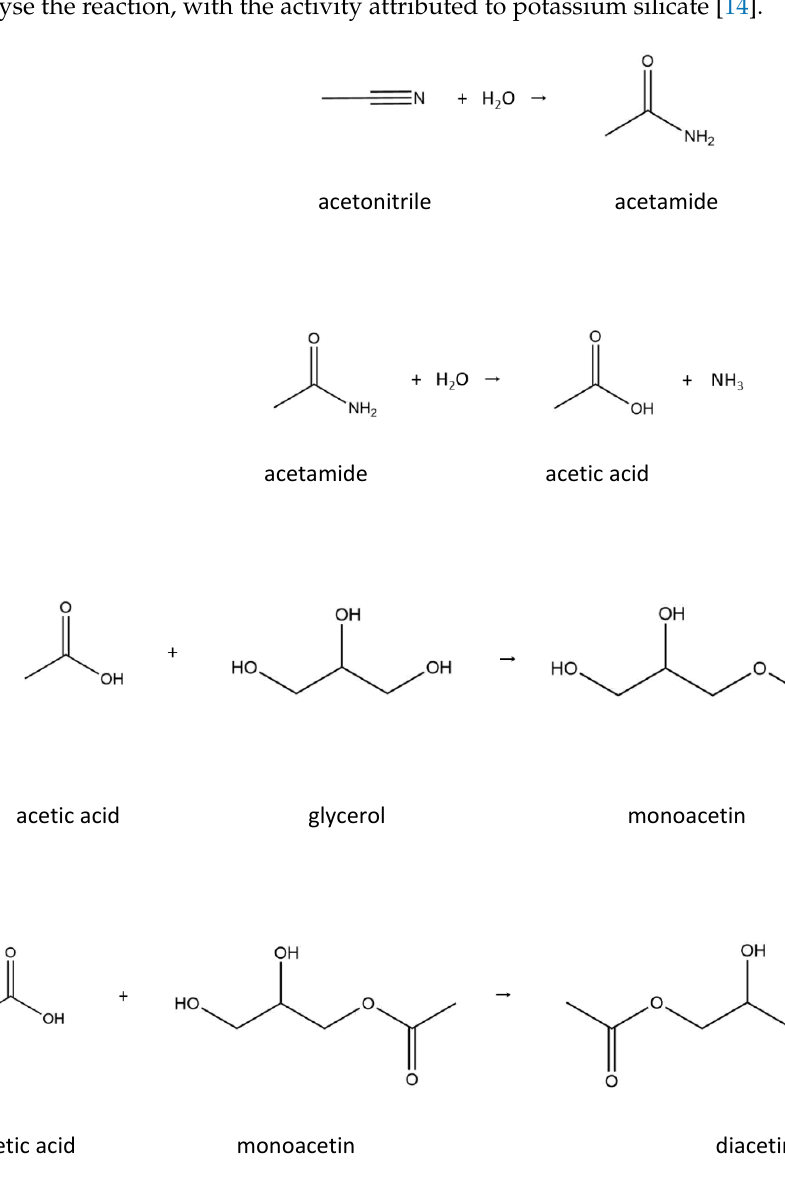
Figure 3. Reactions for the formation of mono-, di- and triacetin from glycerol and acetonitrile.